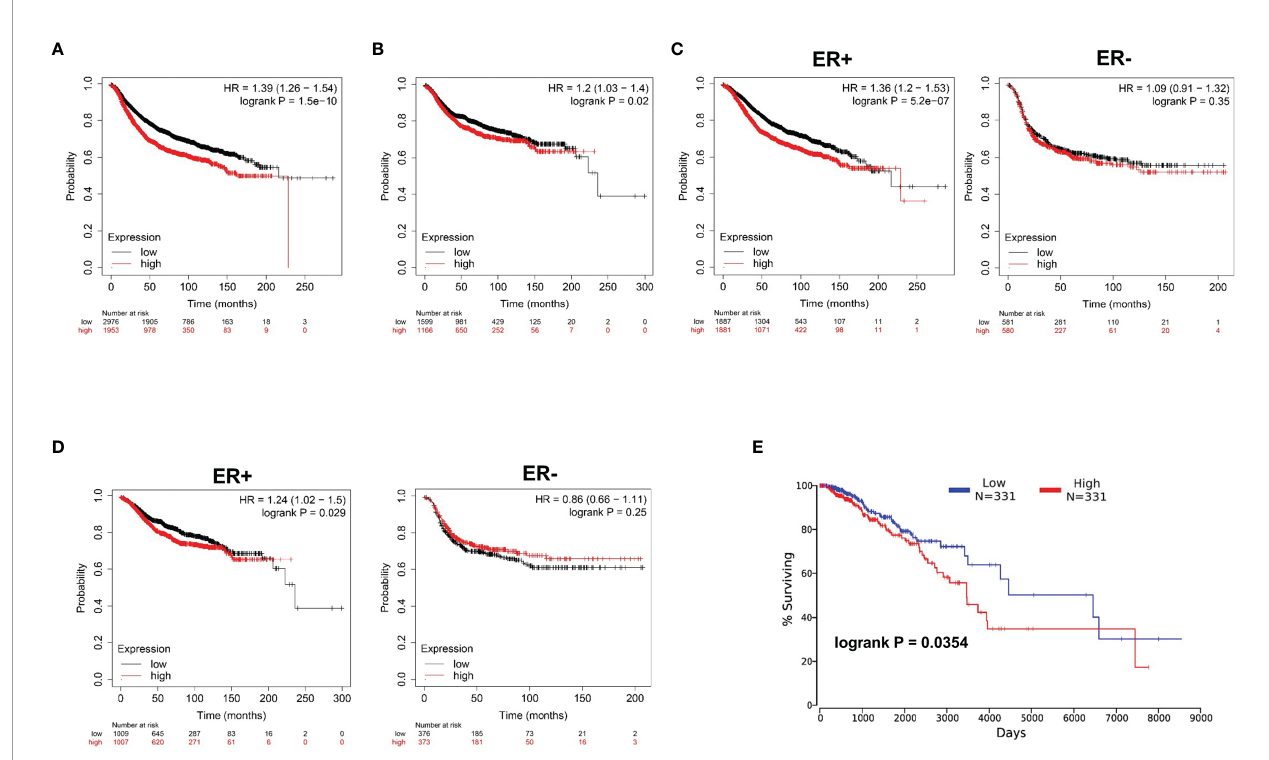
FIGURE 3 | Clinical survival signi fi cance of NUP37 expression level in BRCA patients. (A) Correlation of NUP37 expression with RFS and (B) DMFS using Kaplan – Meier plotter. Statistical signi fi cance was estimated using a log-rank test. (C) Correlation of NUP37 expression with RFS and (D) DMFS curves calculated by Kaplan – Meier plotter for patients with breast cancer classi fi ed as ER+ (left) and ER − (right) respectively. Statistical signi fi cance was estimated using a log-rank test. (E) Kaplan-Meier curve for OS in BRCA patients grouped by the level of NUP37 expression using OncoLnc. Statistical signi fi cance was estimated using a log-rank